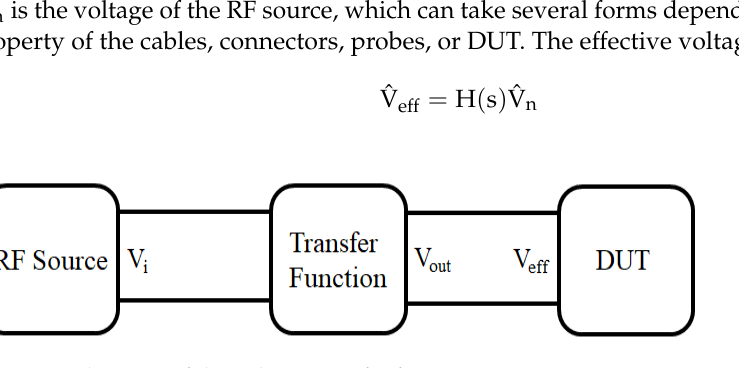
Figure 2. Schematic of the voltage transfer function.